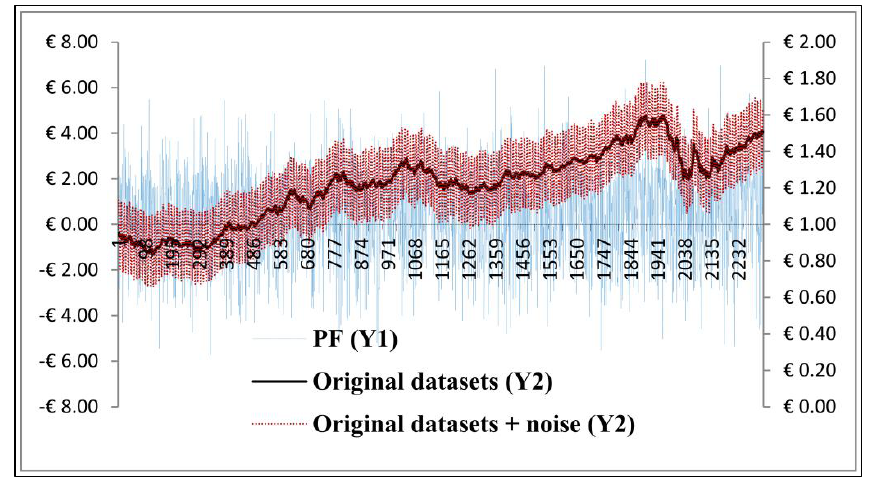
Figure 10. Plots of the original datasets, original datasets + noise, and the Particle Filter (PF)